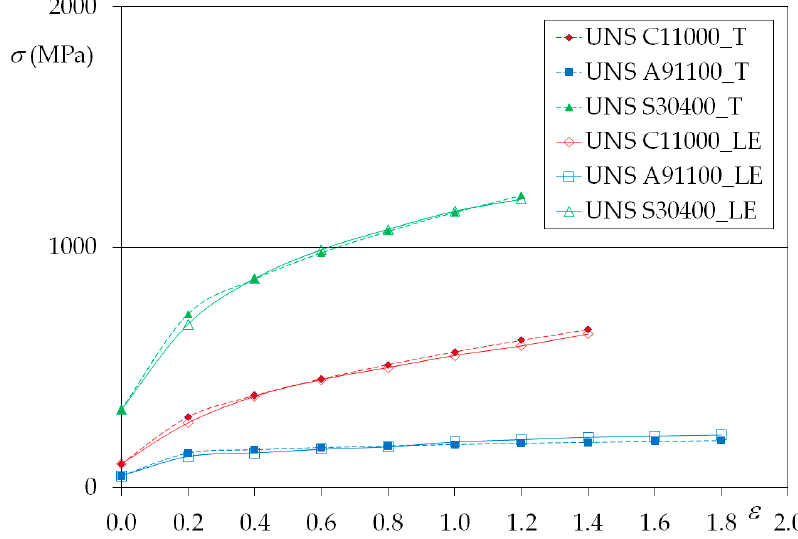
Figure 4. Literature experimental (LE) and theoretical (T) effective flow stress-strain curves for annealed copper UNS C11000, aluminum UNS A91100, and stainless steel UNS S34000. The values of constants (cid:1851) (cid:2868) , (cid:1829) , (cid:1866) and (cid:1829) (cid:2869) have been collected in Tables 1 and 2, the ranges of